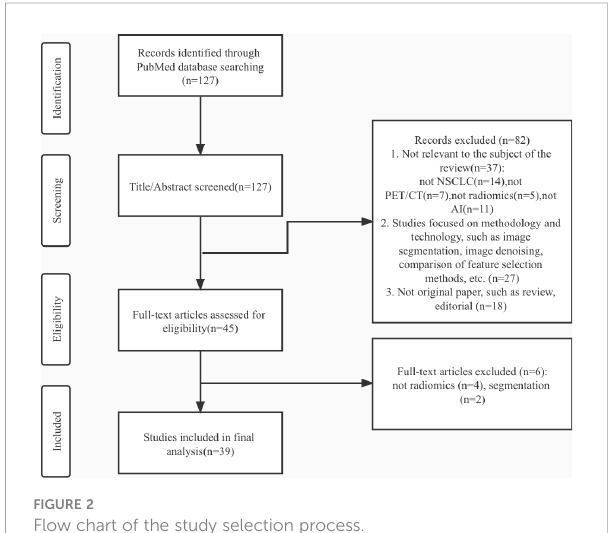
FIGURE 2 Flow chart of the study selection